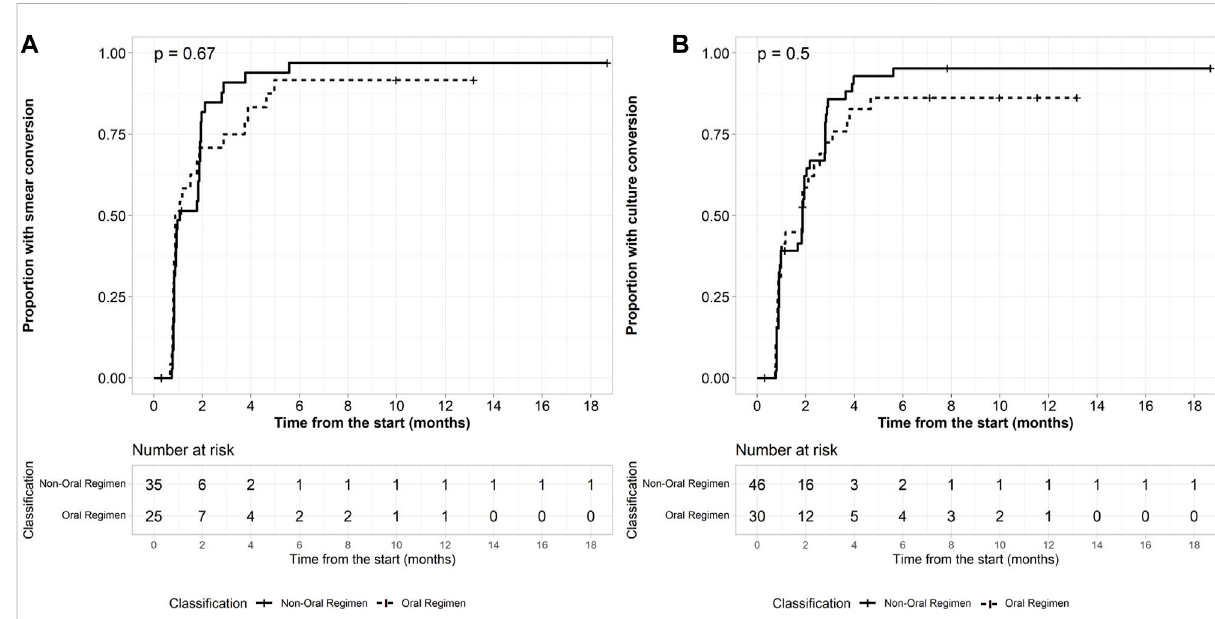
FIGURE 1 Baselineloadpredictsconversion. (A) Timetosmearconversioninpatientswithpositivemicrobiology (B) Timetocultureconversioninpatients with positive